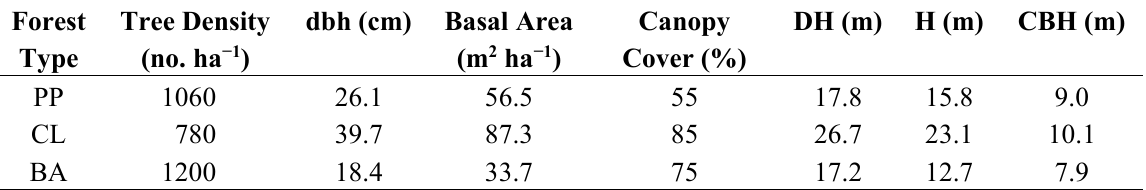
Table 1. Stand characteristics. dbh = mean diameter at breast height; DH = dominant height; H = mean tree height; CBH = mean live crown